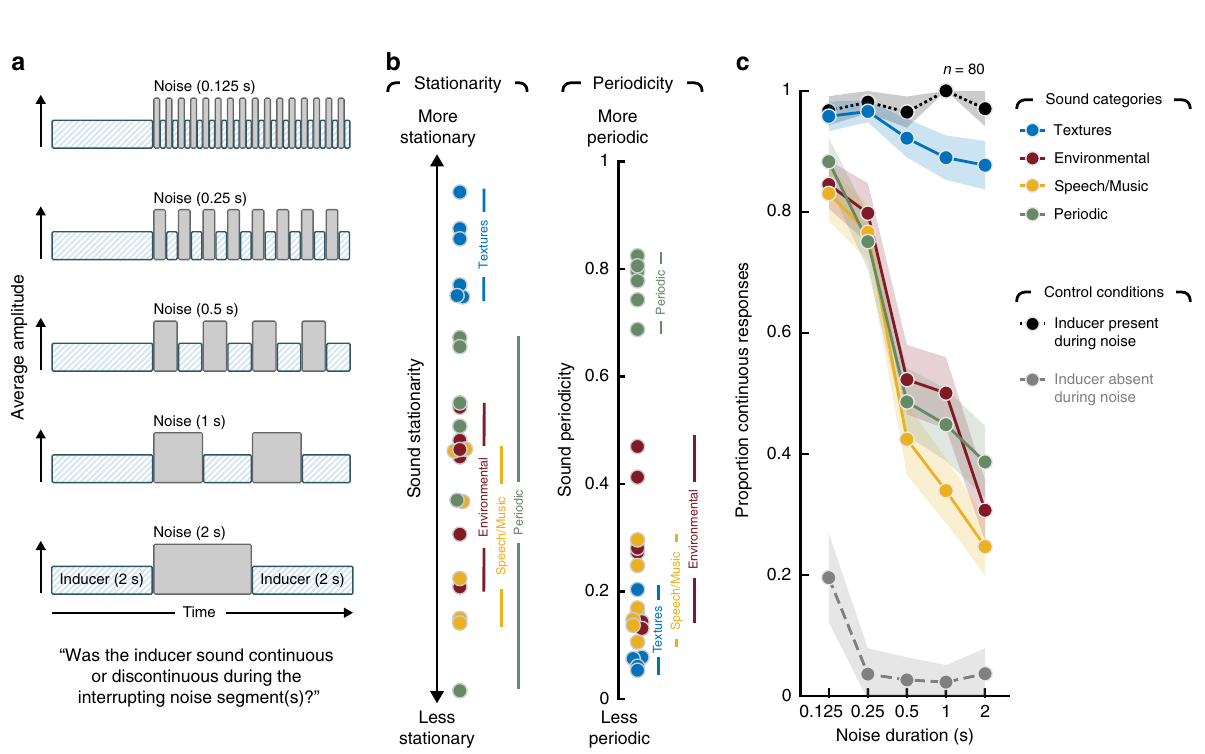
Fig. 2 Experiment 1 — illusory continuity across natural sounds. a Schematic of stimulus and task. On each trial, one of 80 real-world sound recordings was interrupted with masking noise. Listeners reported whether the inducer sound continued during the noise. Here, and in other fi gures, height of inducer and noise segments in stimulus schematic symbolizes the relative sound level (in this case with the noise higher in level than the inducer). b Control conditions. Top left: inducer was physically and audibly present during the interrupting noise. Bottom left: inducer was physically and audibly absent during the noise. In both cases, the noise was 6 dB lower in level (quieter) than the inducer, such that the inducer was detectably present during the noise in the top condition, and unambiguously absent during the noise in the bottom condition. Right: results of control conditions of Experiment 1a (online). c Reliability of results across in-lab and online experiments. Each dot plots the results for one of the 80 sounds (the proportion of participants who judged the sound to continue during the noise). d Reliability of online results across participant splits. Plot shows the split-half correlation for the online experiment for one example split. The Pearson correlation was averaged over 10,000 random splits of participants. e Stationarity measure (negative logarithm of standard deviation of statistics measured in different sound segments). Segment durations varied from Δ t = 125 ms to Δ t = 2 s. f Results of Experiment 1a (proportion of trials on which the inducer was judged to continue during the noise). Sounds are sorted by stationarity (the value of which is denoted by the bar color). g Mean proportion of continuous responses from Experiment 1a (with white noise masker) plotted vs. sound stationarity (also denoted by dot color, to aid comparison to f ). Top: excerpt of white noise masker signal, displayed as a cochleagram. h Mean proportion of continuous responses from the mean noise condition of Experiment 1b plotted vs. sound stationarity. Conventions are as in ( g ). Top: excerpt of mean noise masker signal, displayed as a cochleagram. The mean noise is visibly less stationary than the white noise. Error bars plot SEM